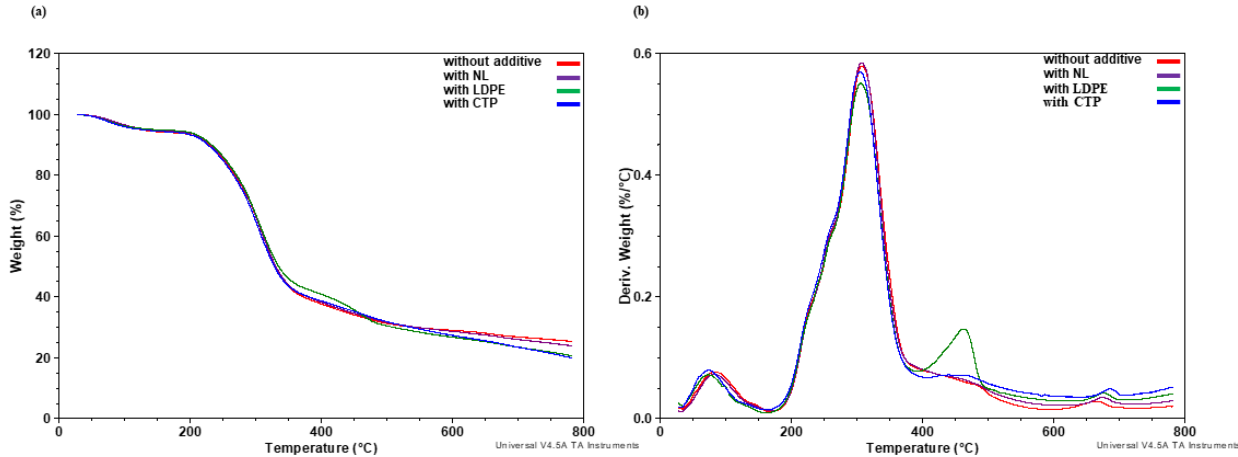
Figure 4. The TGA ( a ) and DTG ( b ) curves of volatiles of densified PH sample and PH blends with additives.